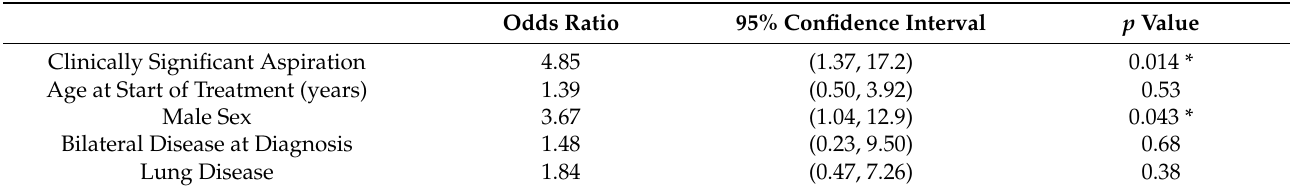
Table 3. Multivariable